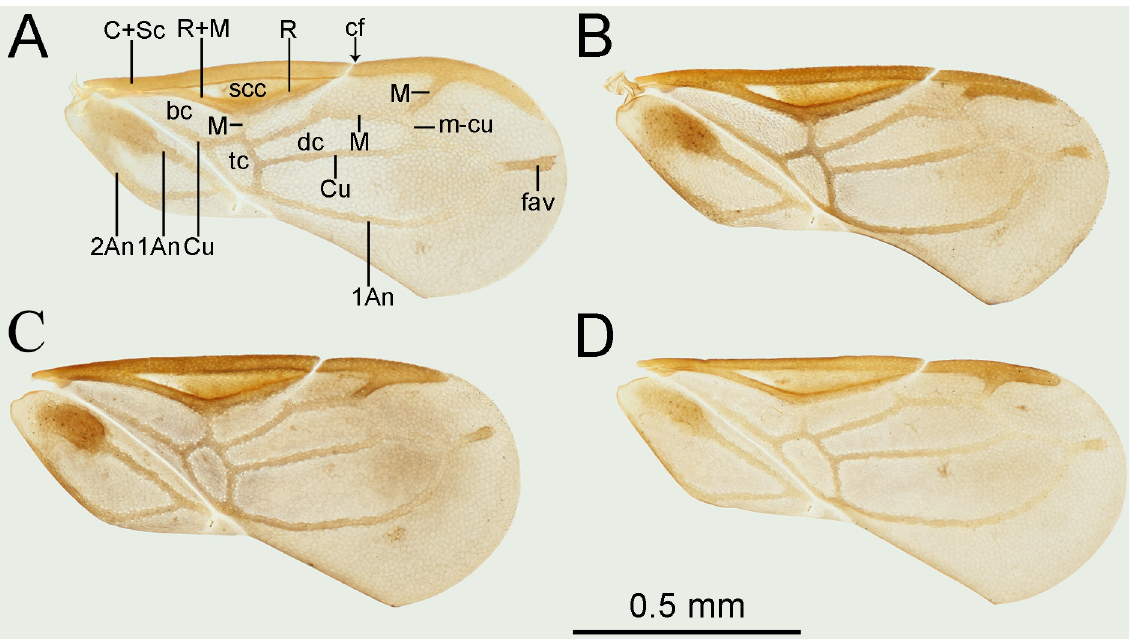
Fig. 27. Forewings of Kokeshia spp., dorsal view. A . K. redeii sp. nov., paratype, ♂ (SYSBM). B . K. renae sp. nov., paratype, ♂ (SYSBM). C . K. weirauchae sp. nov., paratype, ♂ (SYSBM). D . K. xiei Rédei, Ren & Bu, 2012. ♂